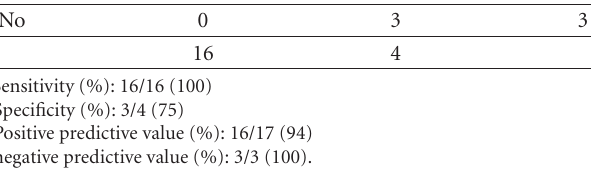
Table 3: Noninvasive imaging findings in 20 patients. No 0 3 3 16 4